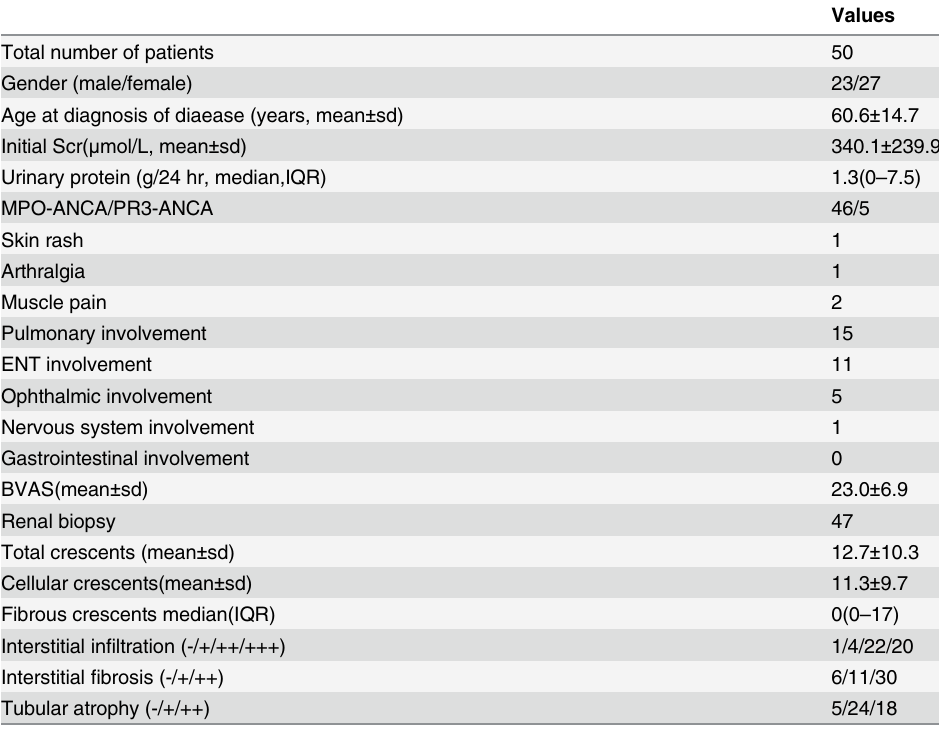
[Abbreviations]: AAV, anti-neutrophil cytoplasmic antibody – associated vasculitis; ANCA, antineutrophil cytoplasmic antibodies; BVAS, Birmingham Vasculitis Activity Scores; ENT, ear, nose, and throat; IQR, interquartile range; MPO, myeloperoxidase antibodies; PR3, proteinase 3 antibodies; s.d., standard deviation; Scr, serum